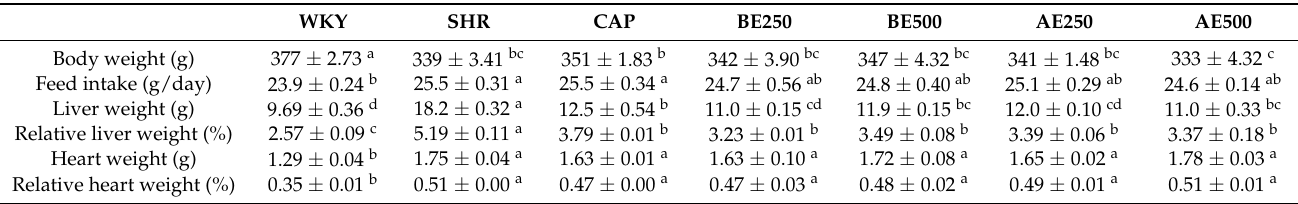
Table 1. Growth performance and organ weights of the rats administered with black soybean or adzuki bean extracts for 8 weeks. WKY: Wistar-Kyoto rats, SHR: Spontaneously hypertensive rats, CAP: 50 mg/kg body weight (bw) of captopril, BE250: 250 mg/kg bw of black soybean extracts, BE500: 500 mg/kg bw of black soybean extracts, AE250: 250 mg/kg bw of adzuki bean extracts, AE500: 500 mg/kg bw of adzuki bean